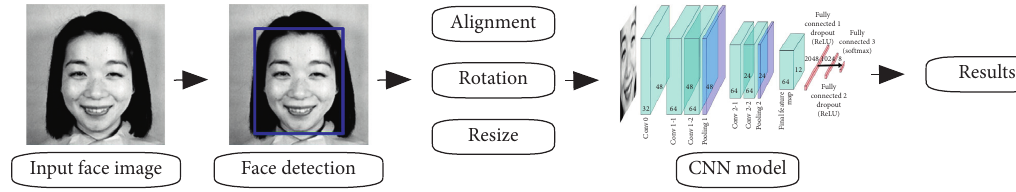
Figure 3: The process of FER.